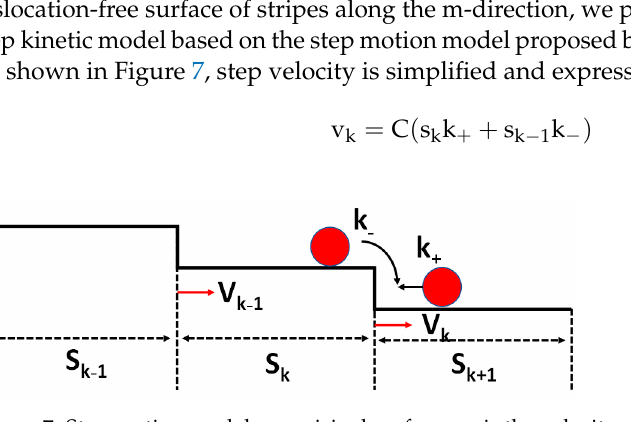
Figure 7. Step motion model on a vicinal surface. v k is the velocity of the kth step while the widths of its upper and lower terrace are s k and s k − 1 , respectively. k + and k − represent adatom incorporation probability from lower and upper terraces, respectively. v k+1 and s k+1 represent the velocity of the (k+1)th step and the width of its lower terrace.